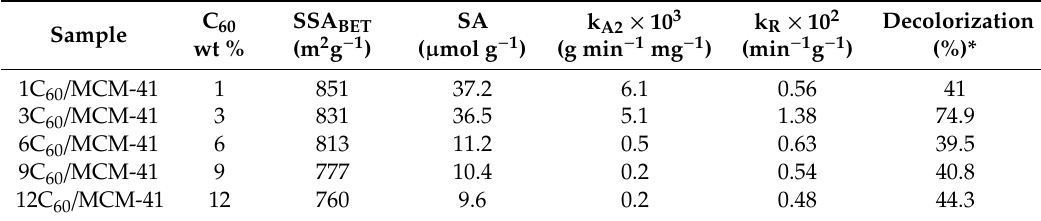
Figure 3. Change of absorbance determined at 475 nm for OG -AA aqueous solutions with the time in the presence of the 3C 60 / MCM-41 and 9C 60 / MCM-41 photo-catalysts as well as for the OG aqueous solution in the presence of the 3C 60 / MCM-41 photo-catalyst. The values on the y -axis are normalized over the absorbance at zero time. Table 1. Values of specific surface area (SSA BET ), specific adsorption (SA), rate constants of adsorption (k A2 ) and photocatalytic decomposition (k R ) of Orange G and percentage of decolorization of the aqueous